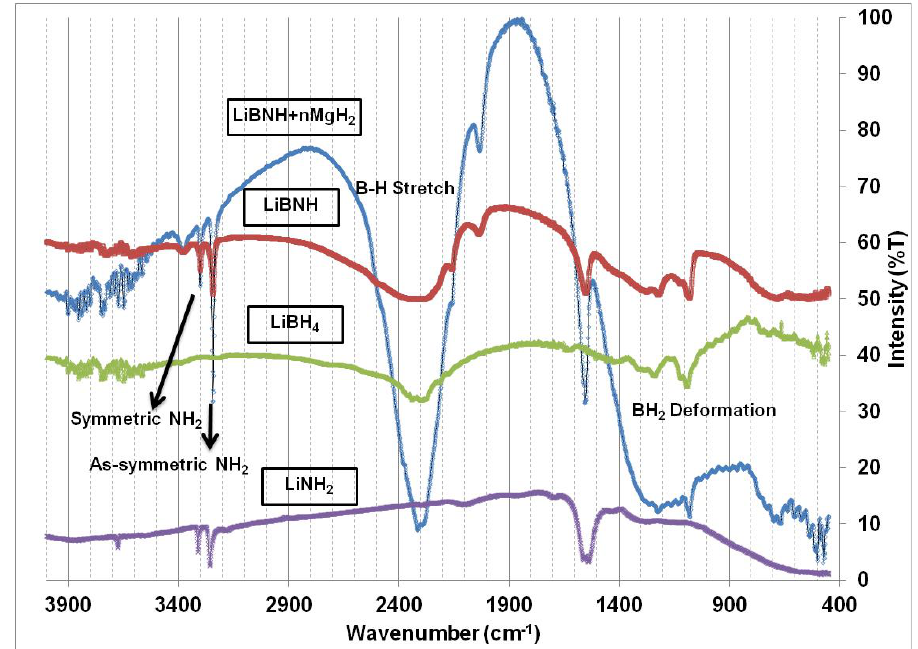
multinary complex 2